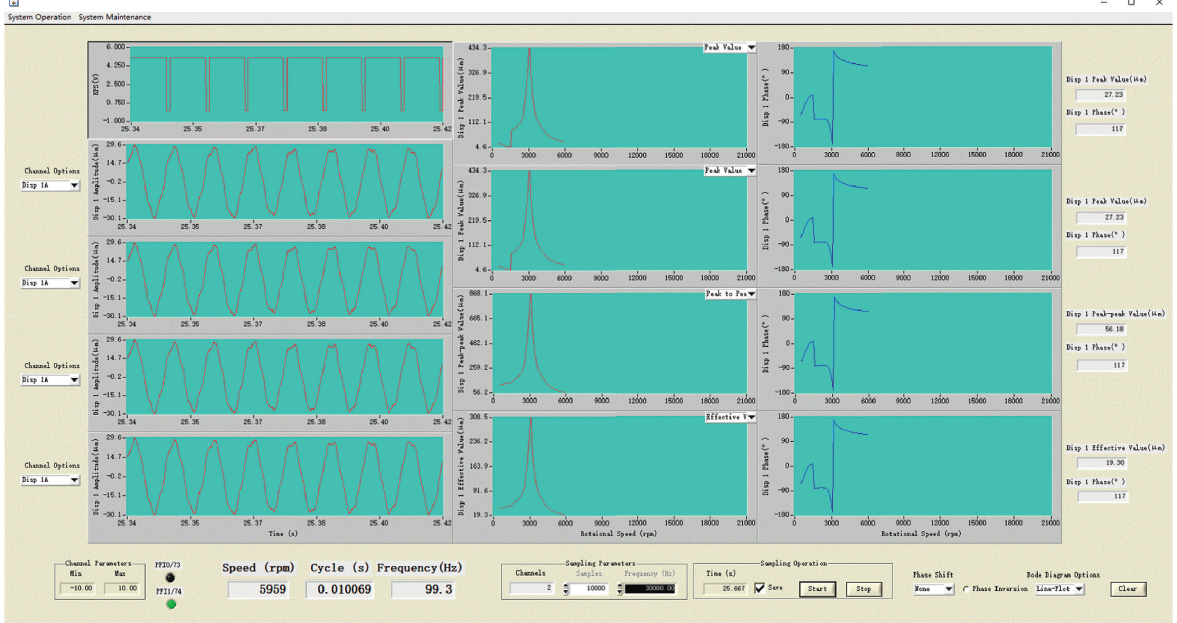
Figure 13: The measuring data of the rotor system before balancing (operating with constant angular acceleration).